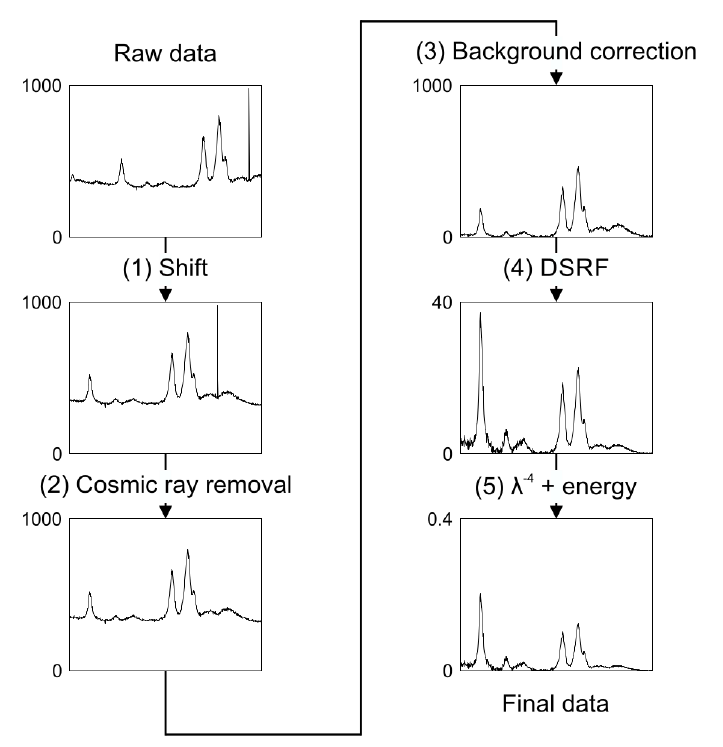
Figure 5. Post-processing of Raman spectral data. It includes renewal of spectral calibration if necessary, removal of artifacts such as cosmic rays or hot/cold pixels, background correction, and correction of the signal intensity for the device response, applied energy, and general spectral efficiency of scattering processes (reproduced with permission from